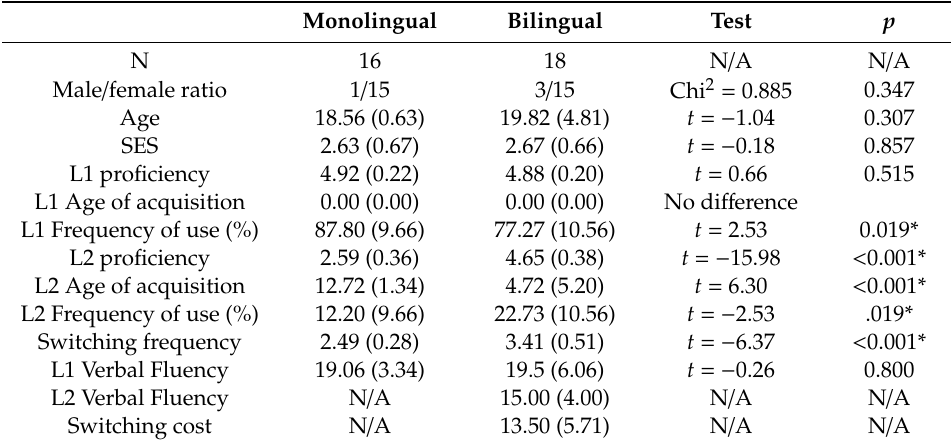
Table 1. Demographic data of the monolingual and bilingual groups, reported as means, with standard deviations between